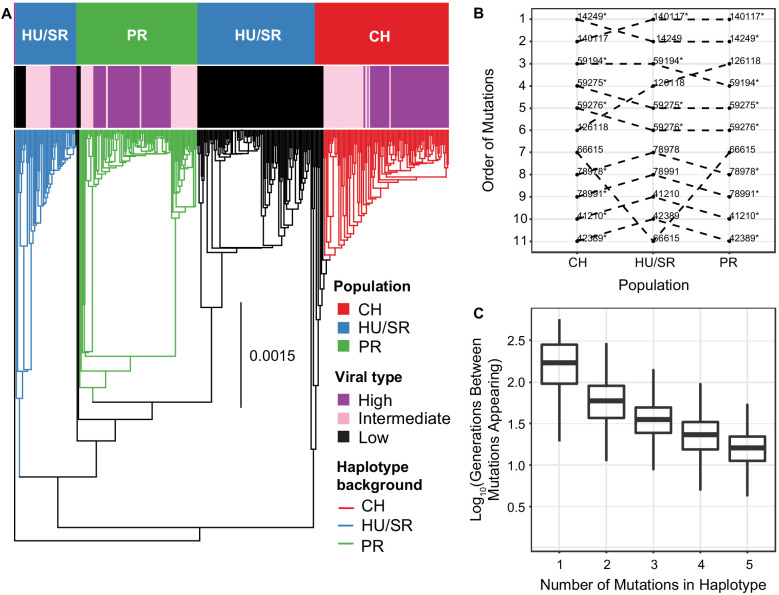
The evolution and maintenance of two viral types.(A) Phylogeographic reconstruction of the spread of DiNV through D. innubila, rooted on the Kallithea virus reference sequence, including a reconstruction of the High type evolution (with strains containing all 11 High type variants shown in purple, strains with an intermediate number of high type variants are shown in pink, and strains with no high type variants are shown in black). Branches are colored when the SNPs found in the background for each High haplotype are present in the population, showing that the background differs per population. Black branches show states where branch tips do not contain all the shared High/Low population specific background SNPs. (B) Order of mutations in the viral haplotype appearing in each population. Apart from three mutations the order is consistent between locations. SNP order has been bootstrapped across multiple sample phylogenies, SNPs with bootstrap support of >95% are labelled with a *. (C) The number of generations needed for ‘High titer’ mutations to evolve in simulated populations, given that each mutation increases the mutation rate. The number of generations between each mutation appearing decreases as titer increases.